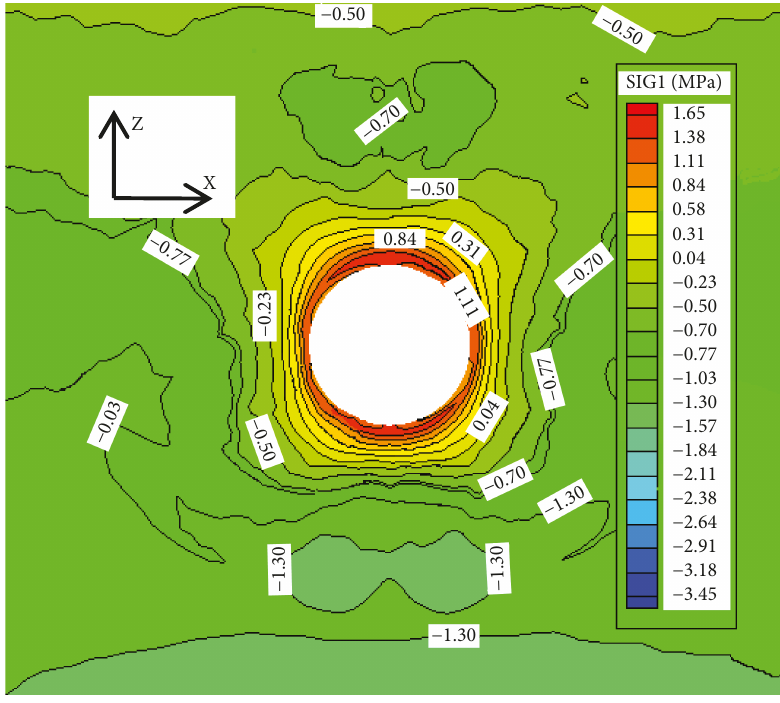
Figure 21: Major principal stress on section